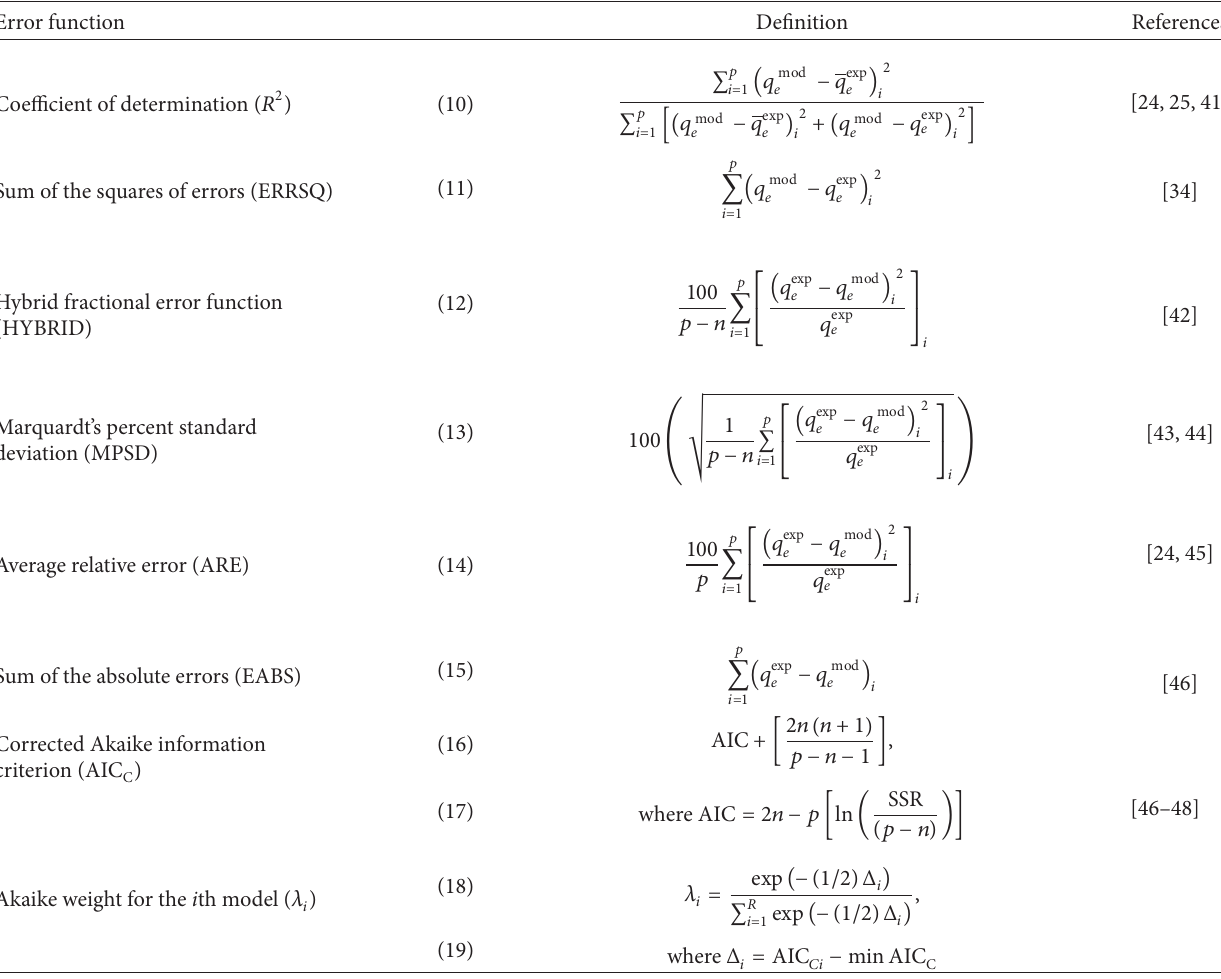
T 2: Error functions used to discriminate between